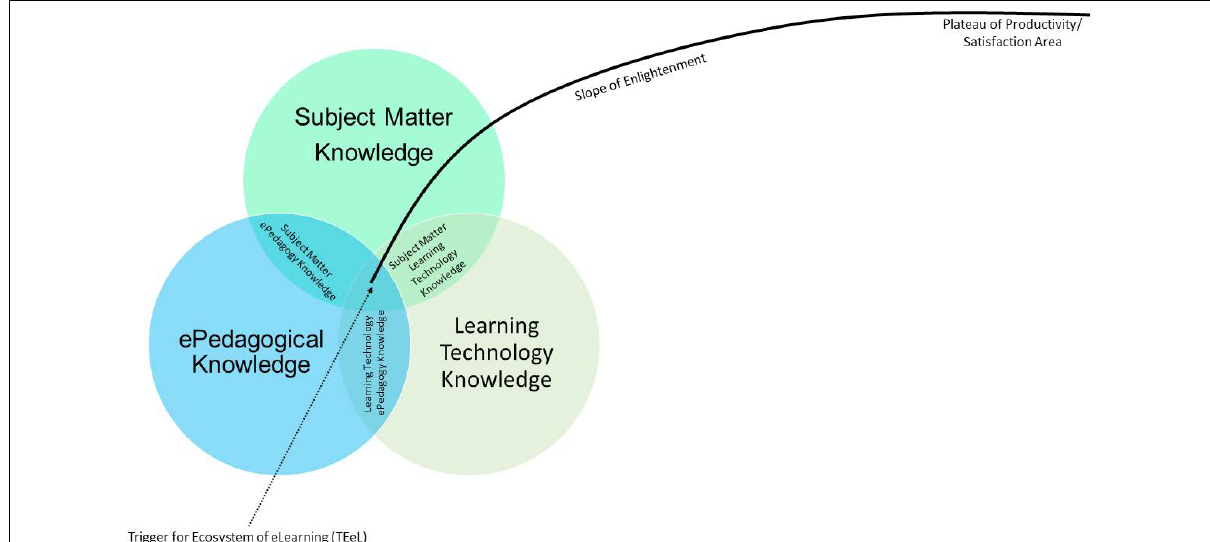
Figure 3: Trigger for ecosystem of e-learning